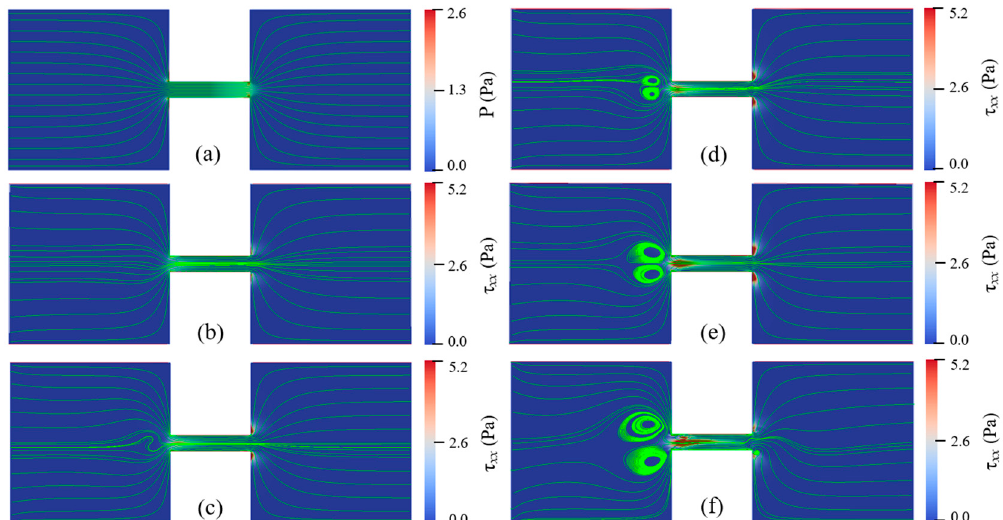
Figure 11. Streamlines of Newtonian fluid and PAA solutions with different concentrations under E app = 600 V/cm at 1.70 s: ( a ) Newtonian fluid, ( b ) c p = 100 ppm, ( c ) c p = 150 ppm, ( d ) c p = 200 ppm, ( e ) c p = 250 ppm, and ( f ) c p = 500 ppm. The color bar represents the elastic normal stress τ xx .